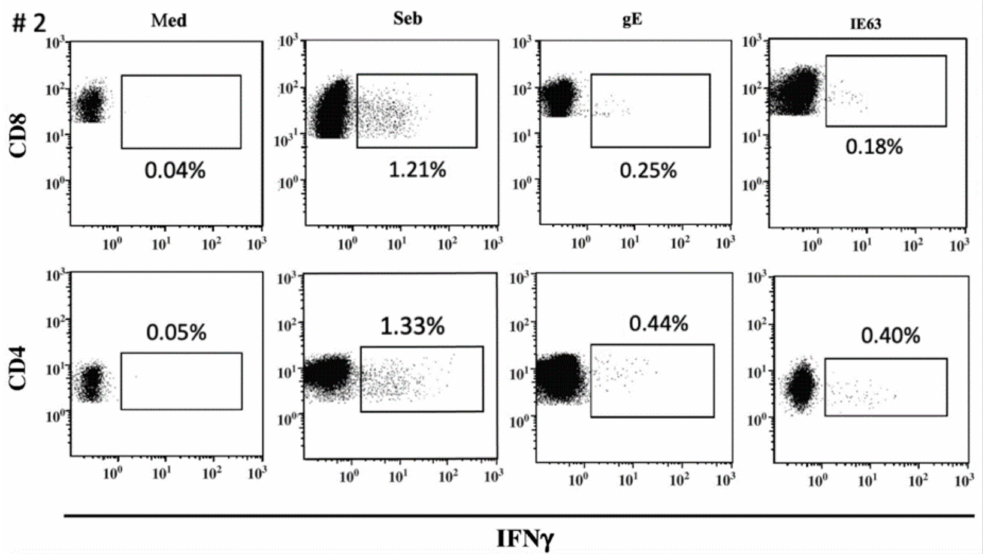
Figure 4. ICS assay VZV-specific T-cell response to gE and IE63 in VZV-seropositive healthy subject